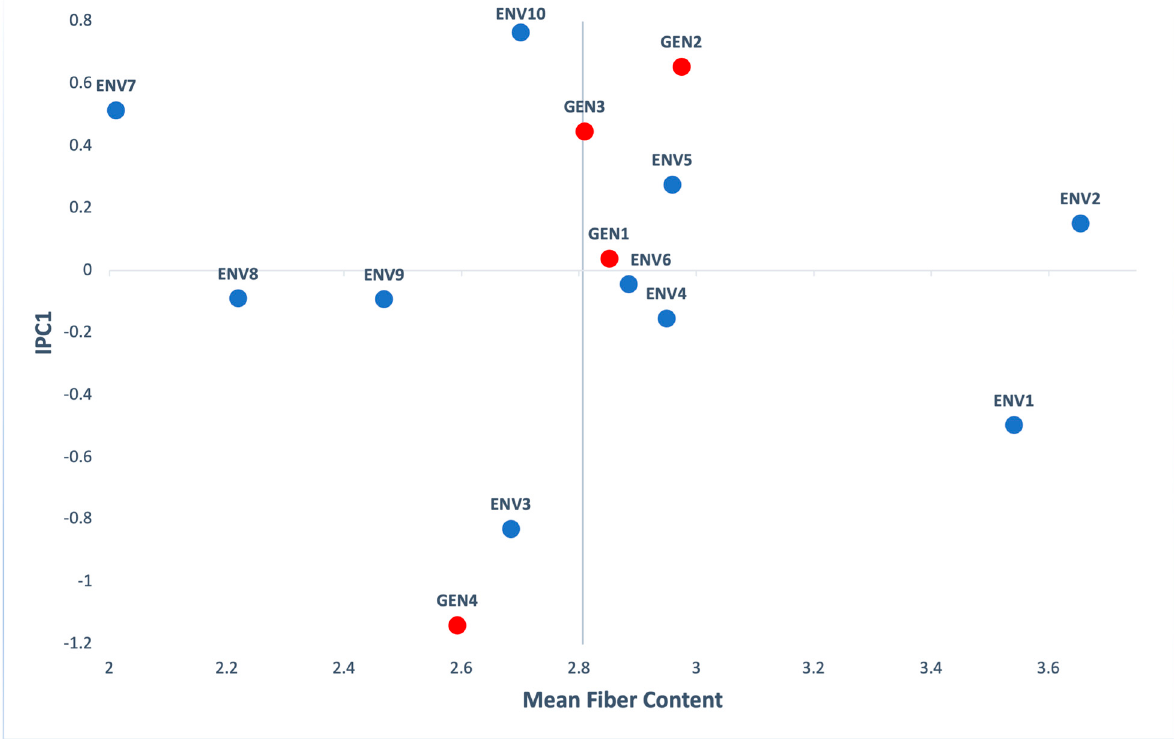
Figure 6. AMMI biplot presenting mean fiber content and the first interaction principal components axis (IPC1) of 4 genotypes (red) evaluated in 10 environments (blue).